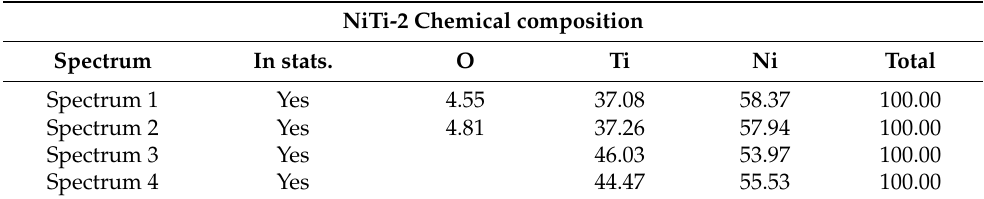
Table 3. Chemical composition of the NiTi-2 corrosion layers identified by EDS analysis.